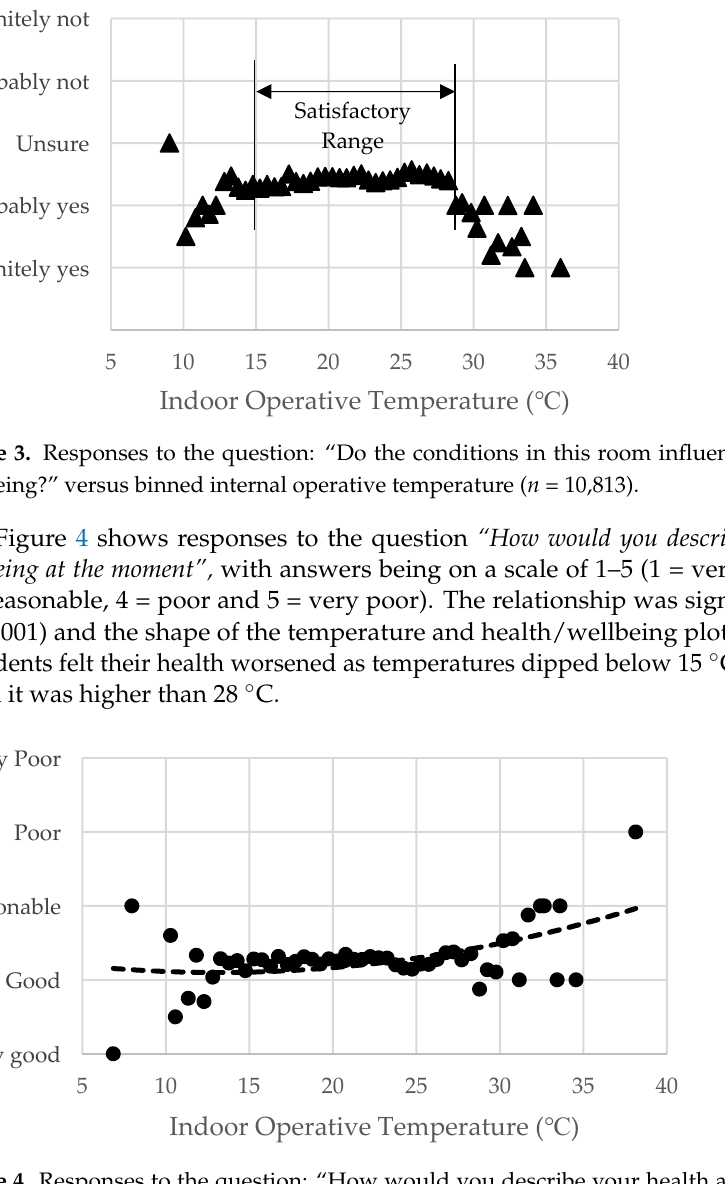
Figure 4. Responses to the question: “How would you describe your health and wellbeing at the moment?” versus binned internal operative temperature (n = 10,813).